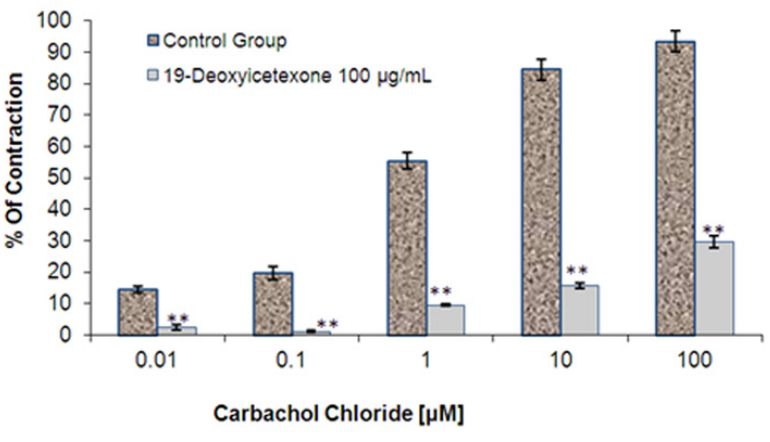
Figure 2. Effect of 19-deoxyicetexone (100 μ g/mL) on the contraction of ileum stimulated with carbachol chloride. The results are the mean of six determinations ± standard error. ** p < 0.001 with respect to the carbachol